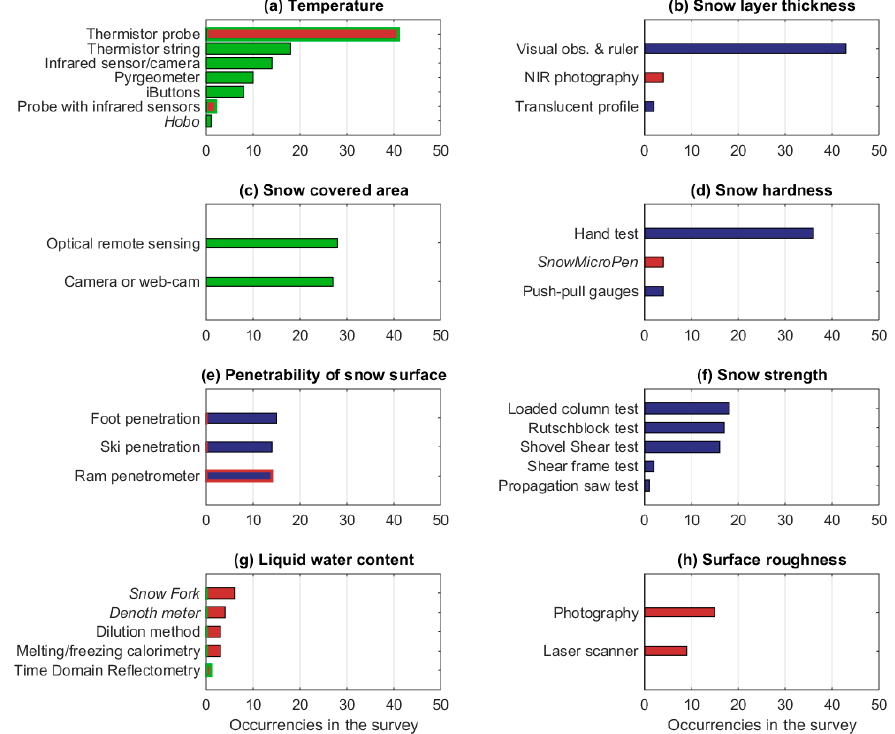
Figure 7. As in Figure 6, but for snow temperature ( a ), snow layer thickness ( b ), snow cover area ( c ), snow hardness ( d ), penetrability of the snow surface ( e ), snow strength ( f ), liquid water content ( g ), and surface roughness ( h ). Different colours denote manual instrument without electronics (blue), manual instrument with electronics (red), manual instrument with or without electronics depending on the version of the instrument (blue with red contour), manual instrument with electronic or fully automatic depending on the version of the instrument (red with green contour), and fully automatic instrument (green).